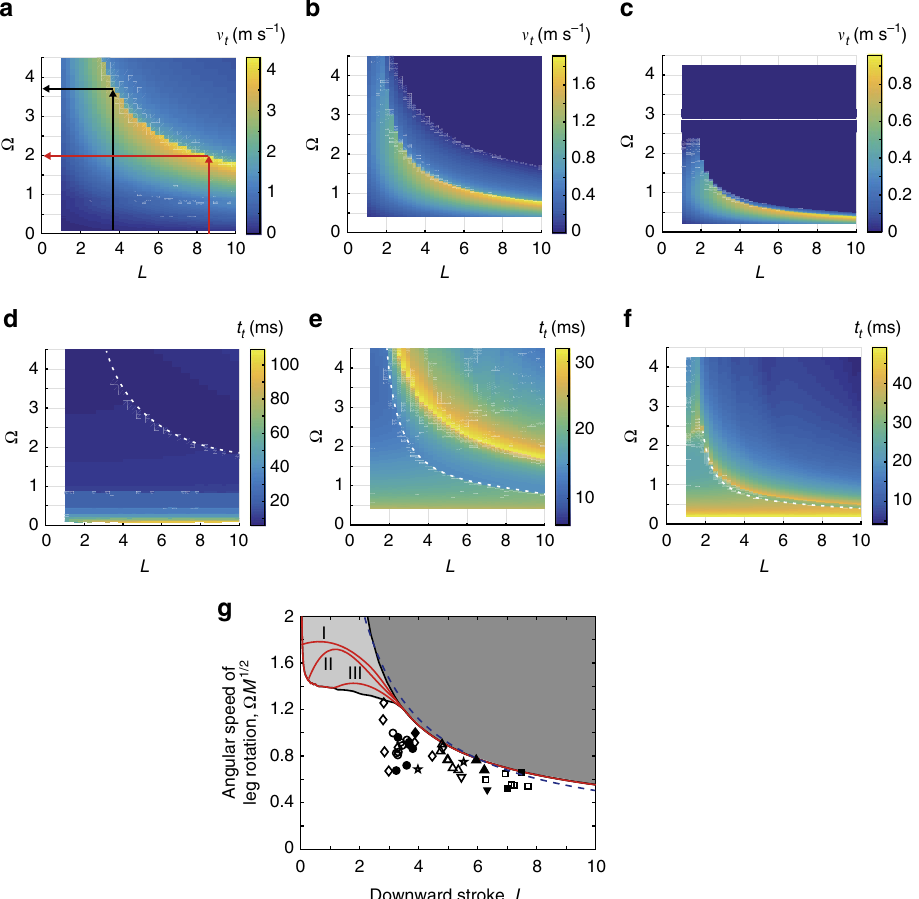
Figure 4 | Theoretical and empirical results of jumping of water striders. ( a – c ) Effect of the dimensionless angular velocity of the leg O and the dimensionless maximum downward reach of leg L on takeoff velocity n t with warmer colours indicating higher takeoff velocity for water strider species of three different sizes expressed in different values of the variable M : M ¼ 0.1 in a ; M ¼ 0.5 in b ; M ¼ 2.0 in c . M represents the ratio of body mass to the maximal mass of water that the legs can displace by pushing against the water surface. Water striders observed in this study have M near 0.5. The arrows in a show that the longer leg indicated by red arrows should move slower, for example, than the leg indicated black arrows to get maximum takeoff speed. ( d – f ) Effect of the dimensionless angular velocity of the leg O and the dimensionless maximum downward reach of legs L on the time taken to escape from water t t with warmer colours indicating longer escape time corresponding to the conditions of a – c , respectively. White dashed lines indicate the boundary of meniscus breaking jump. ( g ) Phase diagram for the three jump modes as a function of O M 1/2 and L : post-takeoff closing (white area), pre-takeoff closing (light shaded area), and meniscus breaking (dark shaded area). The red lines marked with I, II and III indicate the conditions resulting in maximal vertical takeoff velocity with three M in a – c : I with M ¼ 0.1; II with M ¼ 0.5; III with M ¼ 2.0. The dashed line shows the line of O M 1/2 ¼ 4/ L þ 0.1. The phase diagram includes empirical results from the jump characteristics of females (filled symbols) and males (unfilled symbols) of G. remigis (inverted triangles), G. comatus (diamonds), G. latiabdominis (circles), G. gracilicornis (triangles) and A. paludum (squares) with nymph of G. remigis